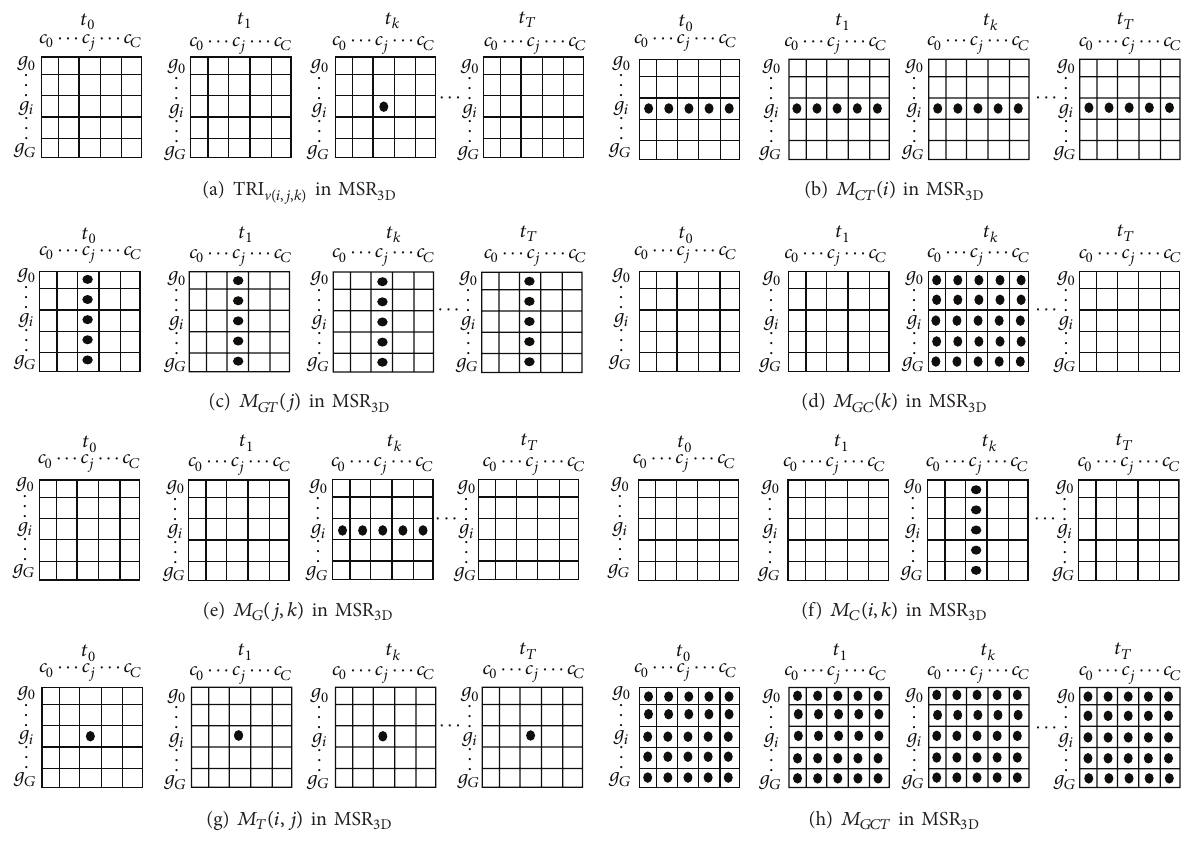
Figure 3: MSR 3 structural members. D Table 1: TriGen algorithm